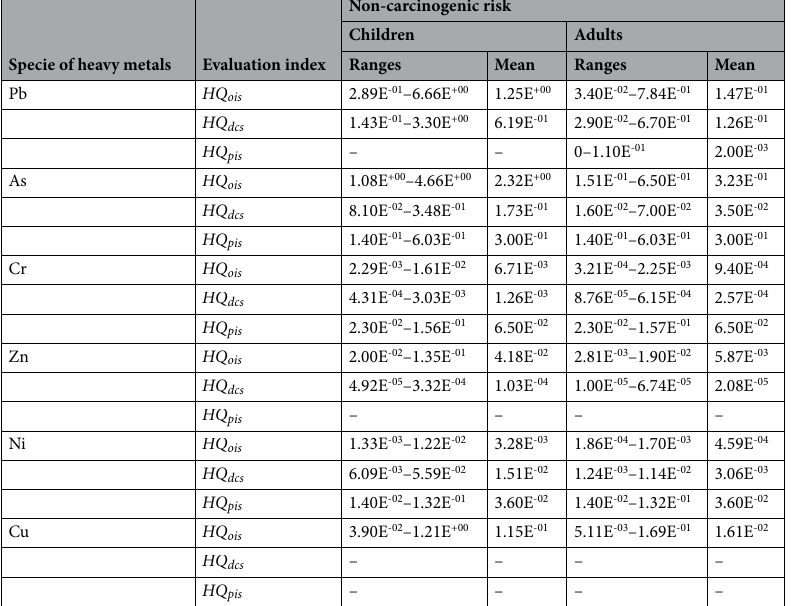
Table 5. Non-carcinogenic risk evaluation of soil heavy metals.